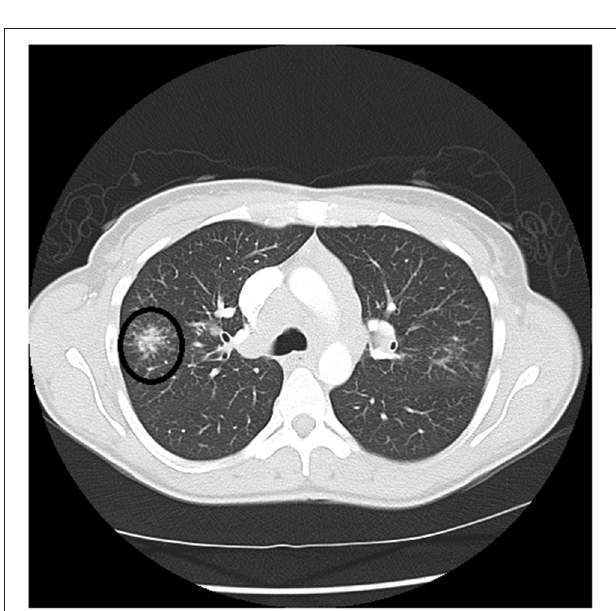
FIGURE 4 | Chest CT scan showing a galaxy sign in sarcoidosis, where micronodules coalesce centrally into a mass lesion